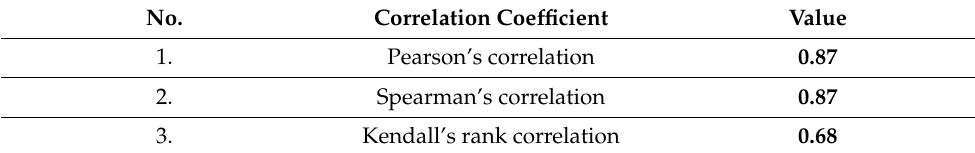
Table 5. Statistical correlation of observed and SWAT-simulated Lhasa River discharge.